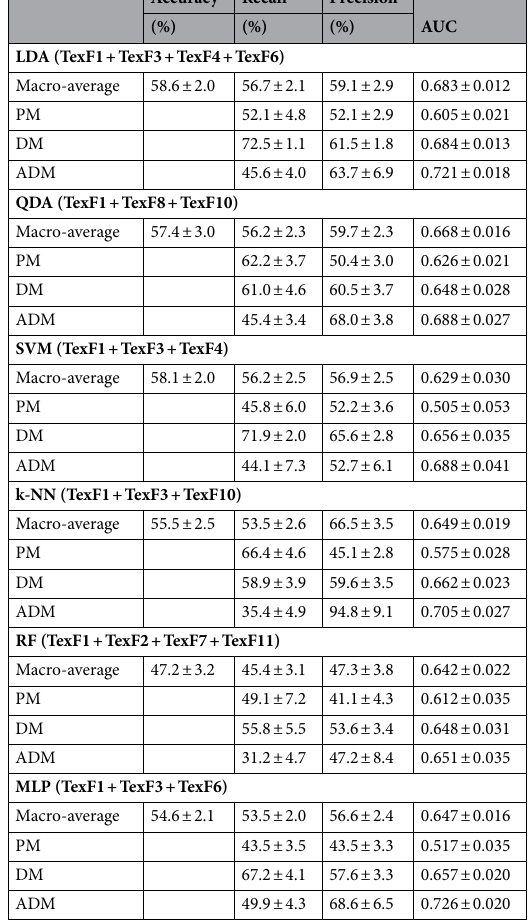
Table 3. Performance of multi-class classifications of IIM groups (original features). Data are means ± standard deviations. Feature name codes are as follows: TexF1 = kurtosis, TexF2 = interquartile range, TexF3 = total energy, TexF4 = cluster prominence, TexF5 = correlation, TexF6 = difference average, TexF7 = imc2, TexF8 = maximum probability, TexF9 = large dependence high gray-level emphasis, TexF10 = dependence non- uniformity, TexF11 = coarseness. LDA linear discriminant analysis, QDA quadratic discriminant analysis, SVM support vector machine, k-NN k-nearest neighbors classifier, RF random forest classifier, MLP multi-layer